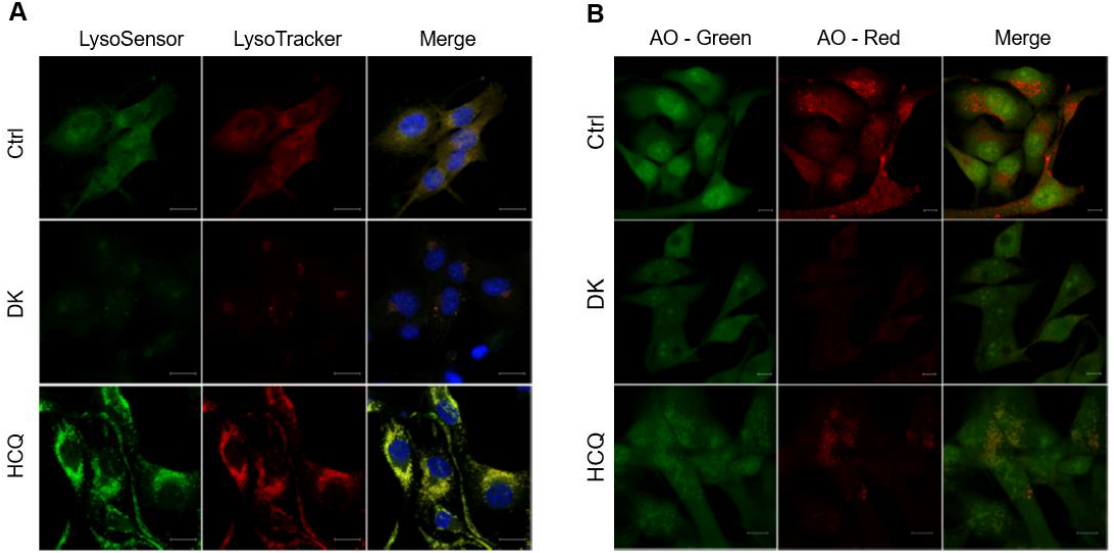
Figure 5. Dieckol (DK) induces lysosomal membrane permeabilization (LMP). ( A ) A375 human melanoma cells were treated with 25 μM DK or 25 μM HCQ for 48 h, followed by staining with LysoTracker red (100 nM) for 30 min and, with a LysoSensor green dye (2 μM) and Hochest 33,342 (15 μg/mL) for 10 min. scale bar = 10 μM. ( B ) Cells were treated the same as in ( A ) and LMP was measured by Acridine Orange (AO) staining under a fluorescence microscopy. Representative immunofluorescence images were shown, scale bar = 10 μM.